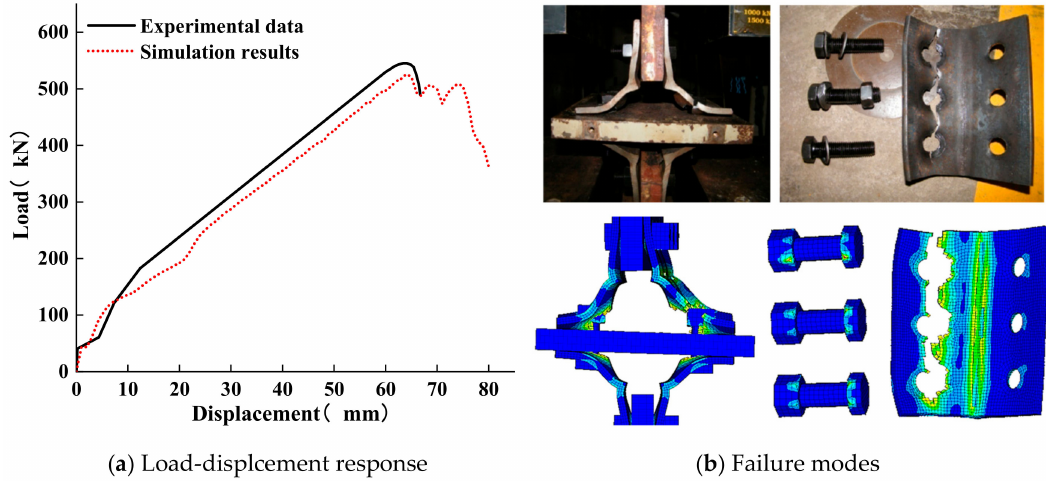
Figure 4. Comparison between simulation and experimental results of A90-8-50-I under